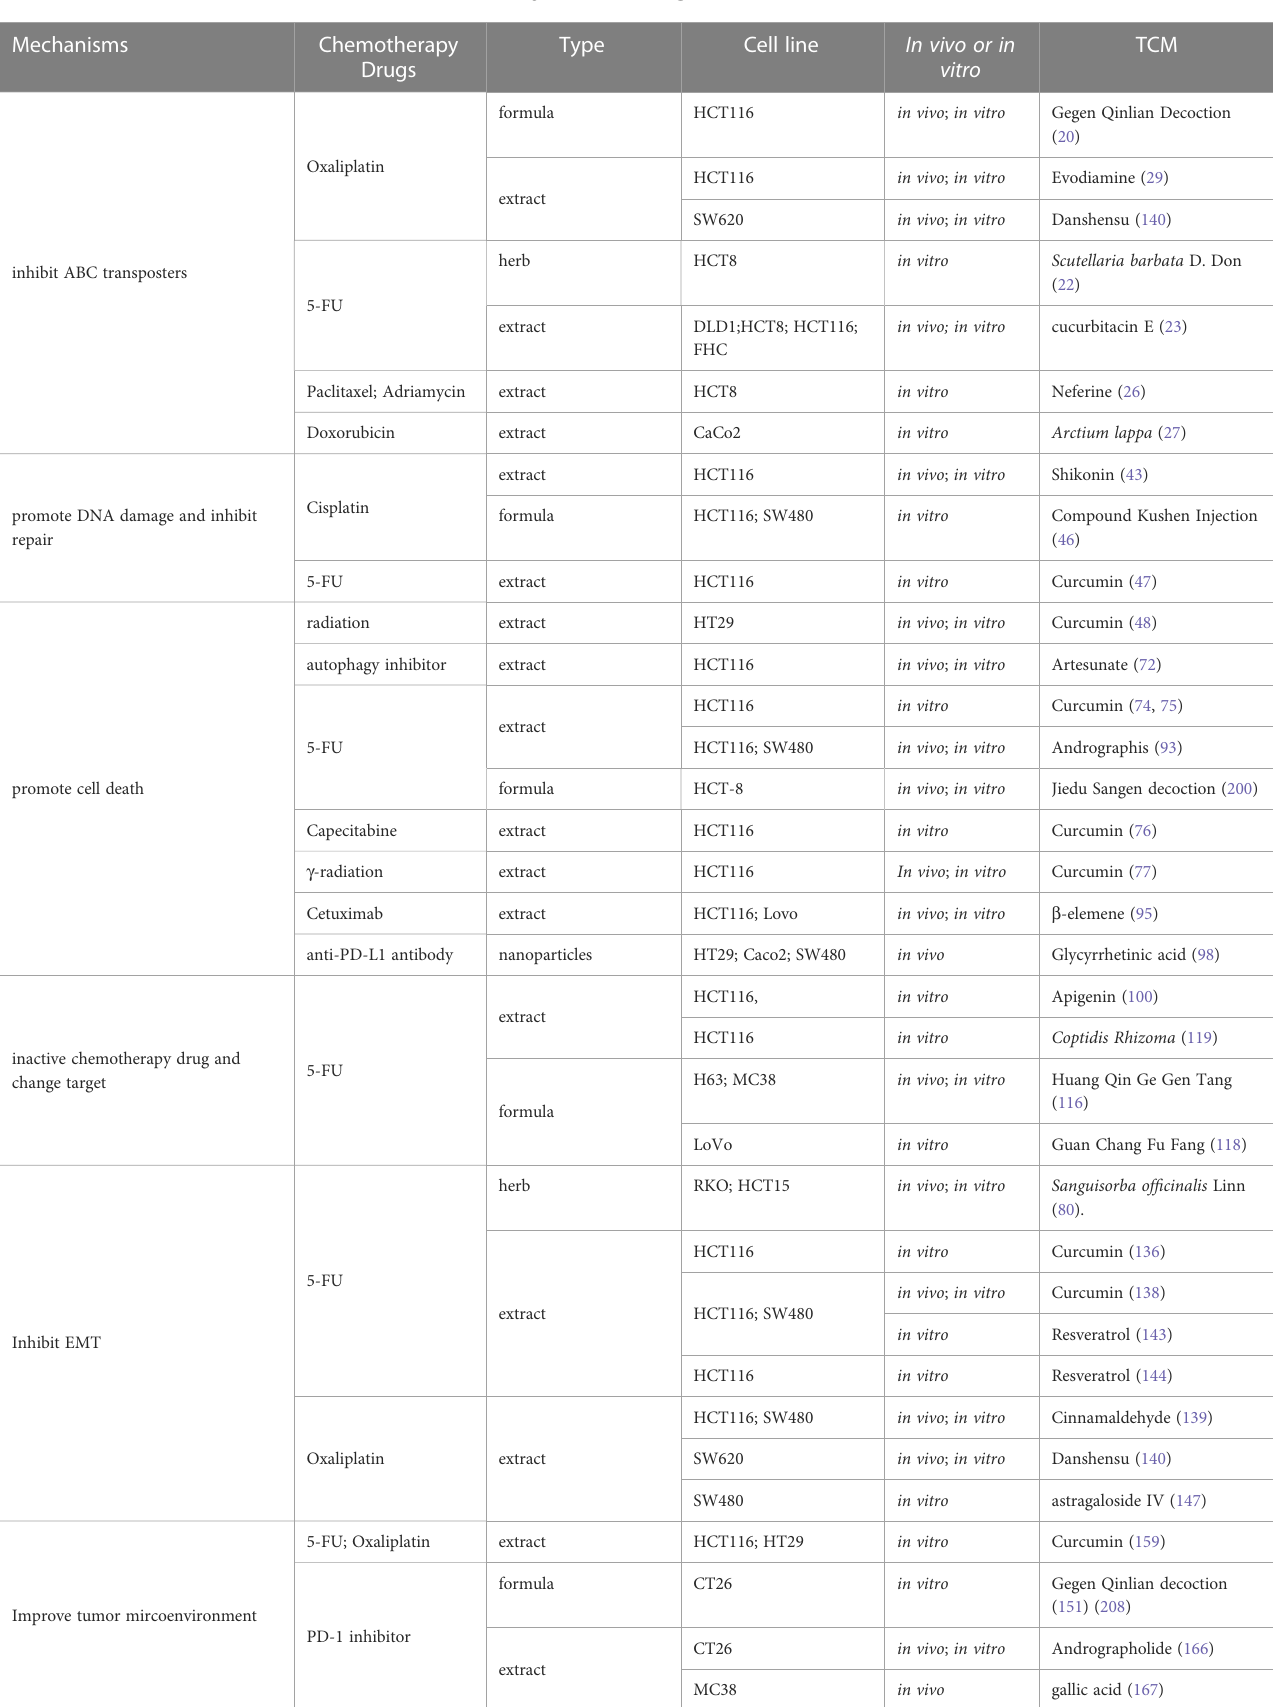
TABLE 1 The main mechanisms of TCM to increase the sensitivity of chemical